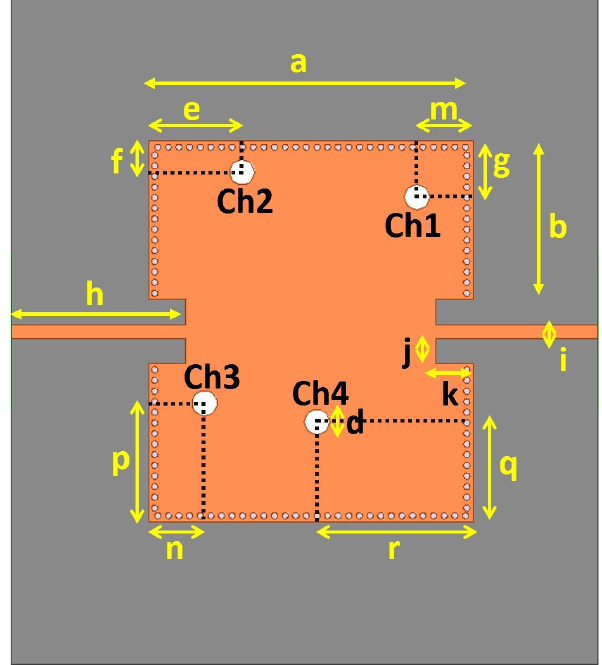
Figure 2. Layout of the proposed substrate integrated waveguide (SIW)